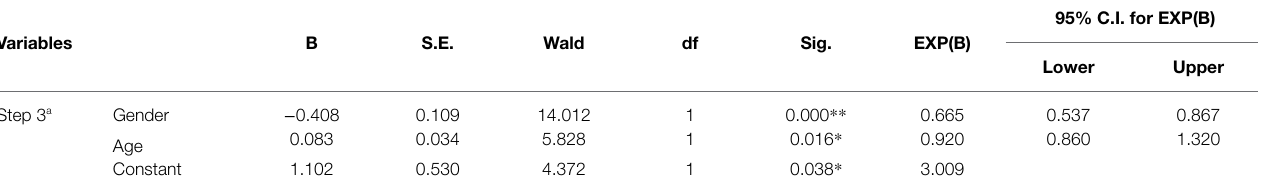
TABLE 7 | Variables in the equation (Emotional polarity features).